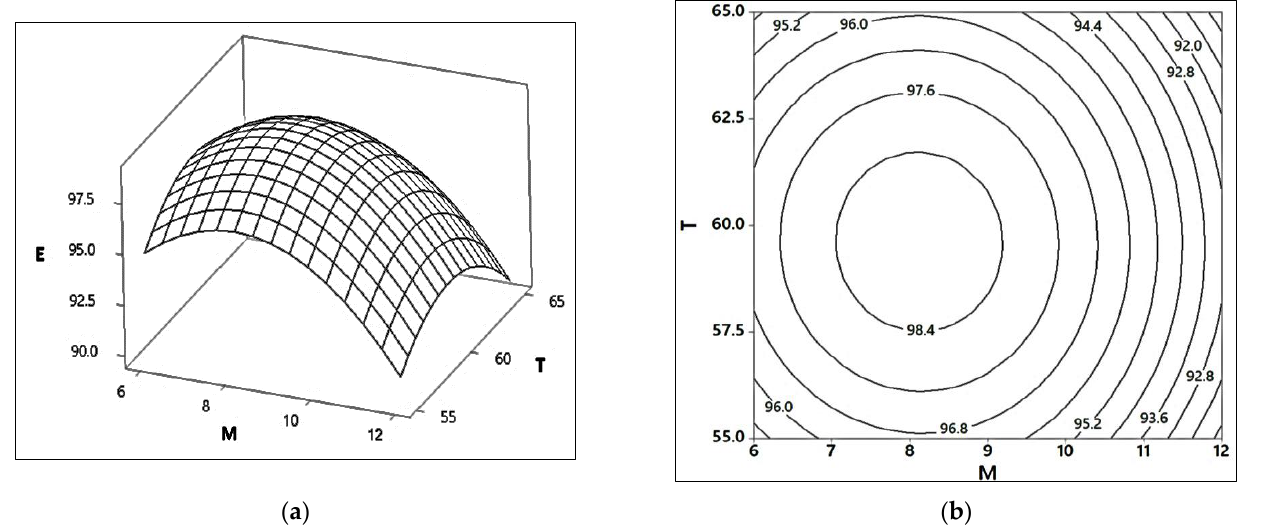
Figure 3. Interaction effect of the methanol to oil molar ratio and reaction temperature on the acidity removal of the WCO esterification process. ( a ) A3D response surface plot of E (%) vs. M (M) and T (°C). ( b ) A 2D contour plot between M (M) and T (°C).